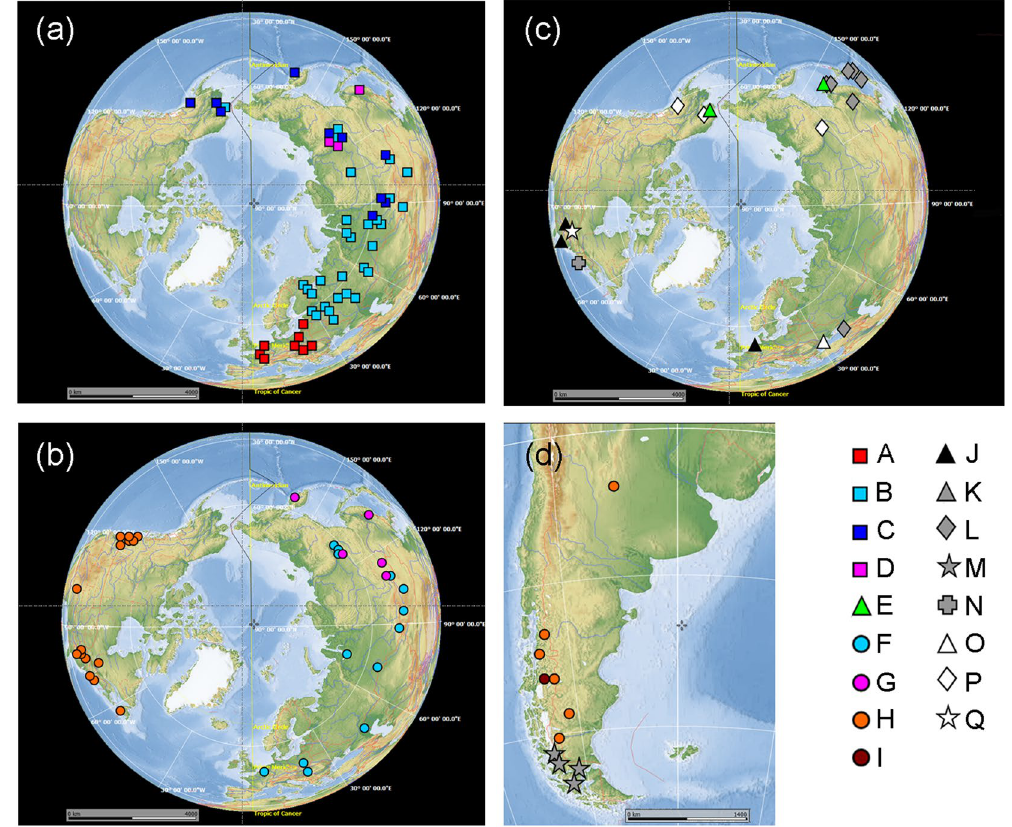
Figure 1. Map of populations studied for the phylogeography of neustonic daphniids ( Scapholeberis and Megafenestra ). Symbols correspond to mitochondrial clades (see Fig. 2) ( a ) Locations for specimens of the S. mucronata species group; ( b ) Populations of Megafenestra (clear symbols), S. microcephala , the S. kingii complex, and the S. armata complex; ( c ) populations of S. rammneri in the Nearctic; and ( d ) populations of S. rammneri and S. spinifera in South America. The base maps are from the public domain atlas in the desktop app, Marble 2.2.20 (http://edu.kde.org/marble). Symbols were placed manually in Adobe Photoshop using the output from DIVA-GIS 7.5 (https://www.diva-gis.org/) as a